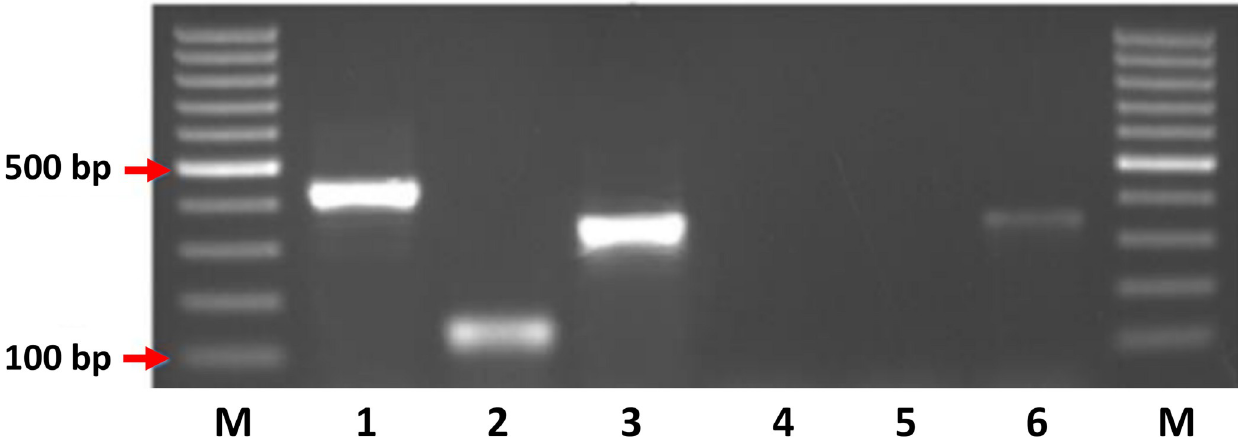
Fig 3. Image showing the relative sizes of the mITS PCR reaction for T . congolense Savannah (1), T . vivax (2) and T . b . brucei (3), extraction negative control (4), reagent negative control (5) and a second T . b . brucei positive control (6).